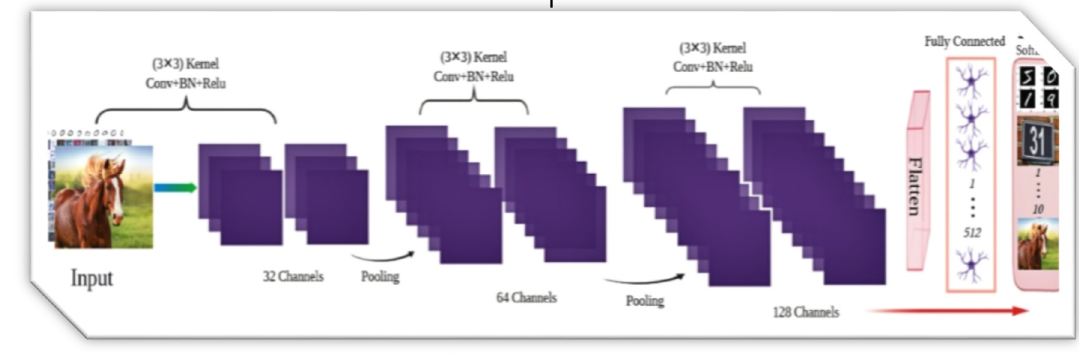
FIG. 4: ARCHITECTURE OF MULTI-BLOCKED MODEL WHERE 3×3 IS KERNEL SIZE, CONV IS CONVOLUTIONAL LAYER, BN IS BATCH NORMALIZATION, RELU IS AN ACTIVATION FUNCTION AND POOLING IS AVERAGE